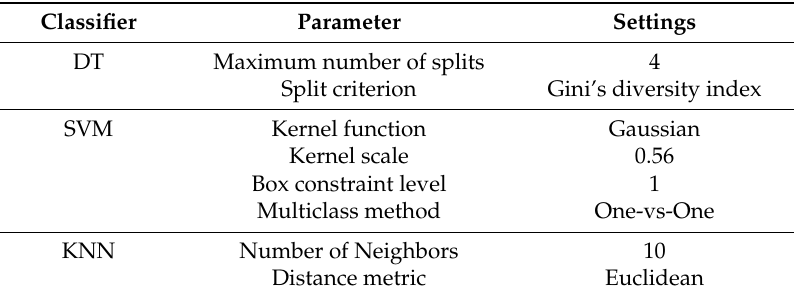
Table 3. Parameters and settings used in DT, SVM, and KNN classifier development. Classifier Parameter Settings DT Maximum number of splits Split